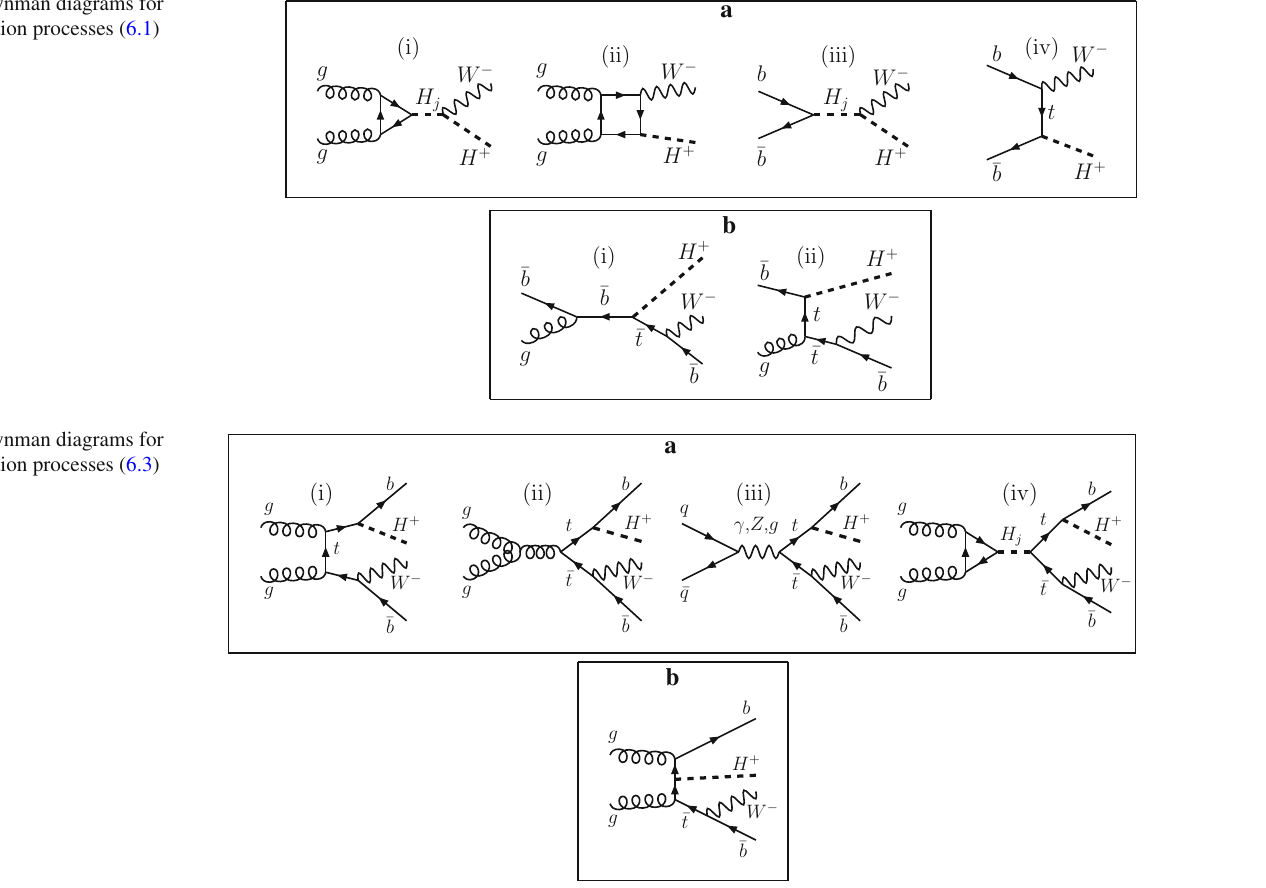
Fig. 7 Feynman diagrams for the production processes (6.1) and (6.2)